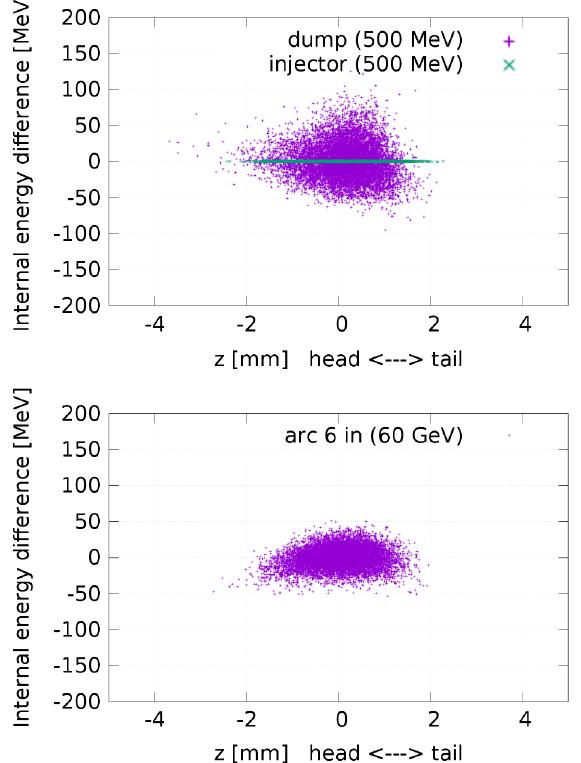
FIG. 11. Longitudinal phase space at the injection and at the dump (top) and at the IP (bottom).